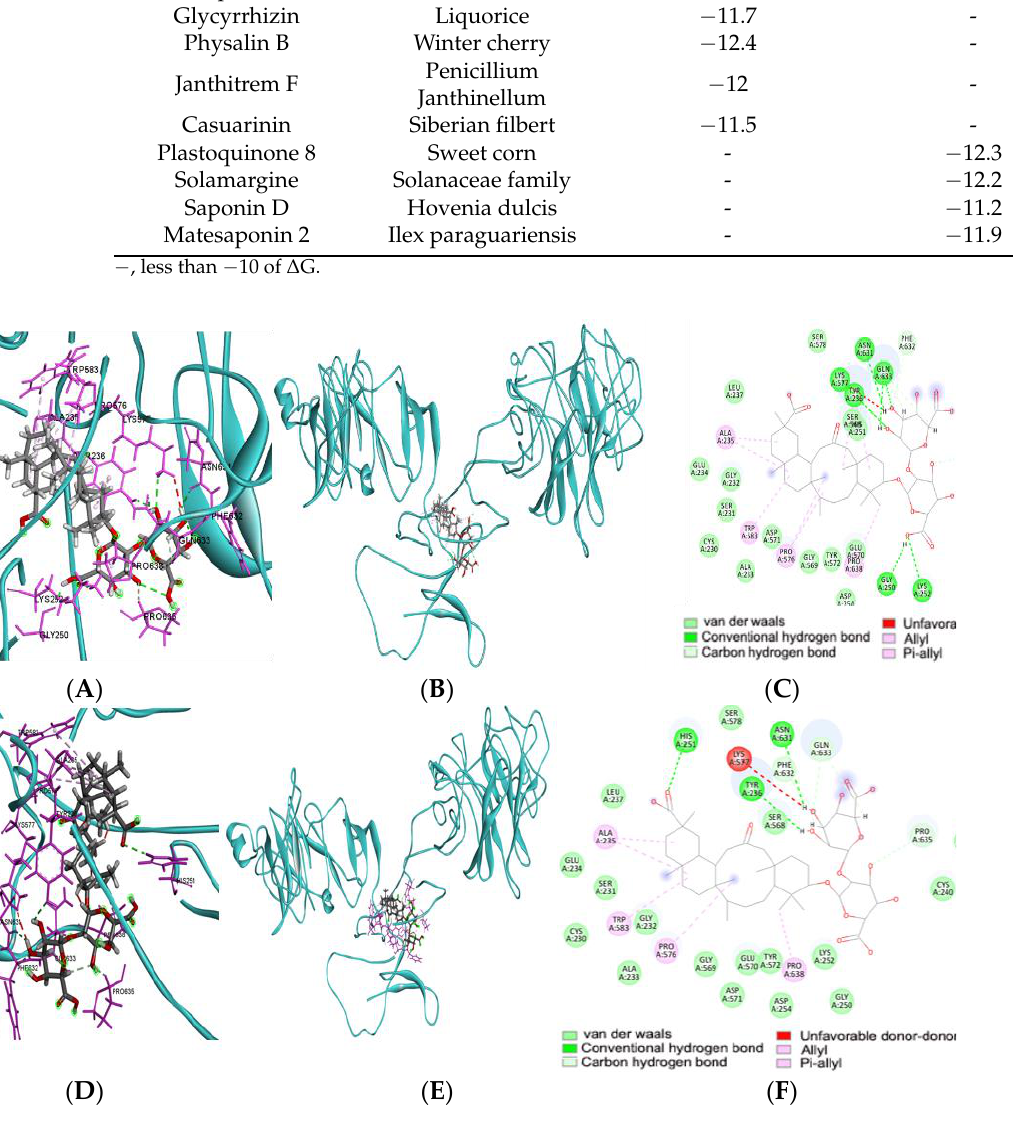
Figure 4. Molecular docking of glycyrrhizin with rs11230563 CD6 active site ( A ) Active site of the wild type of CD6 protein binding to glycyrrhizin (cartoon model). ( B ) Overall binding glycyrrhizin with the wild type of CD6 protein. ( C ) The wild type of CD6 protein’s active site binds glycyrrhizin with an intermolecular binding force. ( D )The active site of the mutated type of CD6 protein binding to glycyrrhizin (cartoon model). ( E ) Overall binding glycyrrhizin with the mutated type of CD6 protein. ( F ) The active site of the mutated type of CD6 protein binding glycyrrhizin with intermo- lecular binding force.